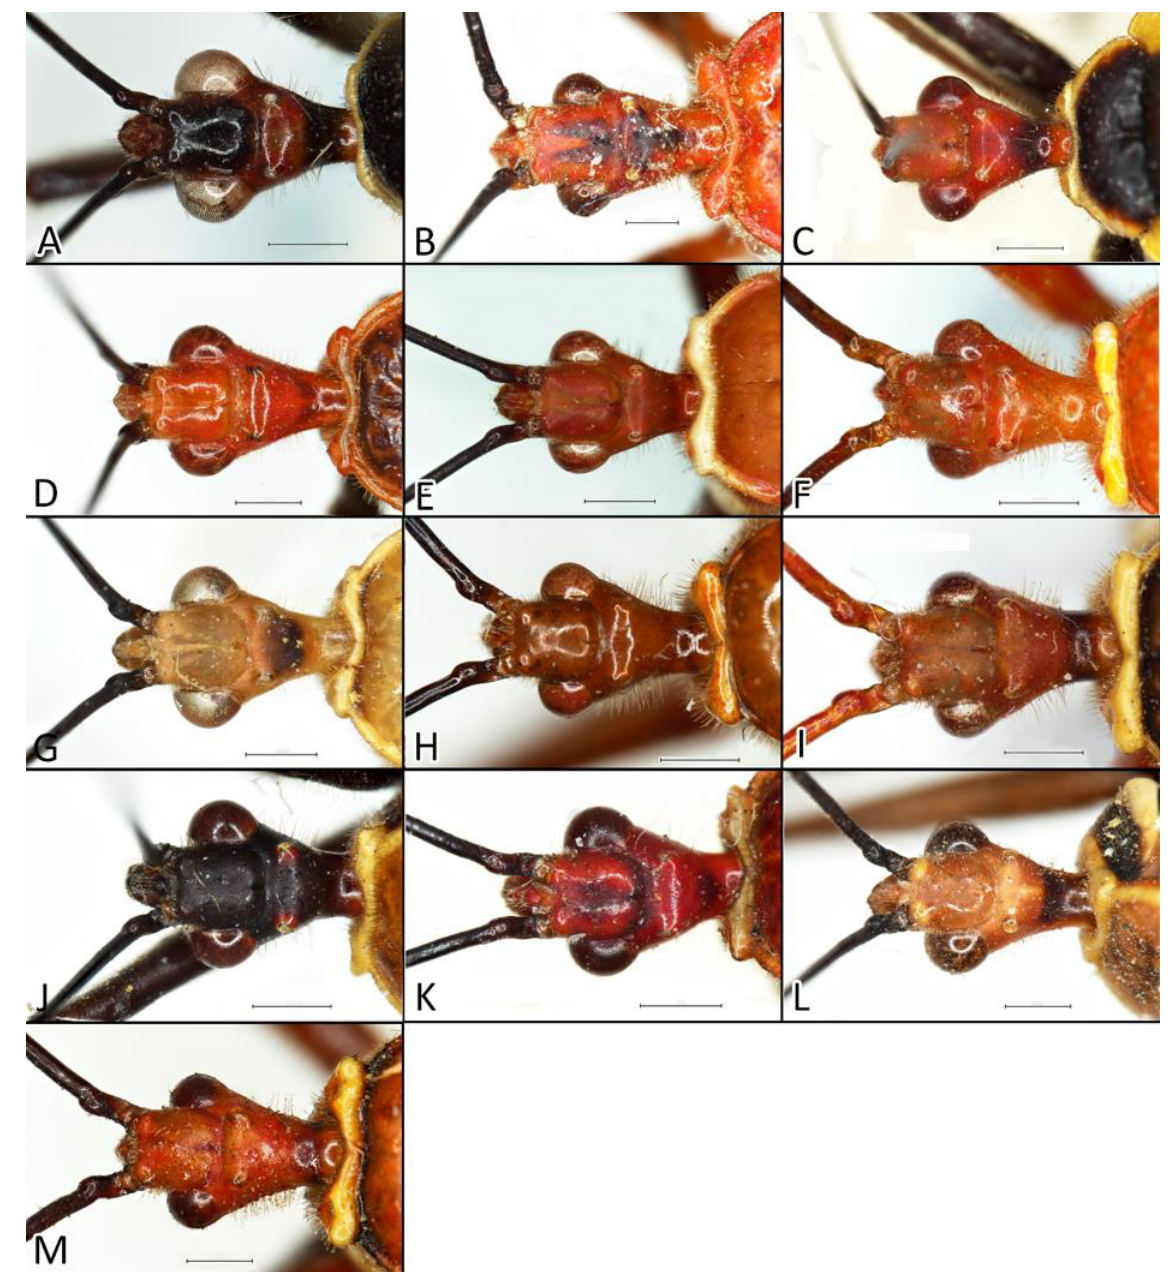
Figure 8. Head in dorsal view: ( A ) Phonoctonus bifasciatus Villiers, 1948; ( B ) P. caesar Haglund, 1895; ( C ) P. elegans Varela, 1904; ( D ) P. fairmairei Villiers, 1948; ( E ) P. fasciatus (Beauvois, 1805); ( F ) P. grandis Signoret, 1860; ( G ) P. immitis Stål, 1865; ( H ) P. luridus Miller, 1950; ( I ) P. lutescens (Guérin-Méneville & Percheron, 1834); ( J ) P. nigrofasciatus Stål, 1855; ( K ) P. picta